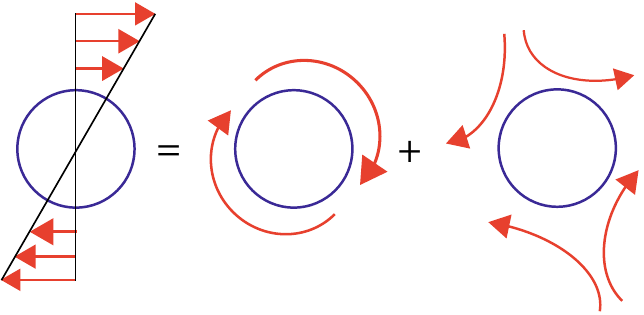
Figure 2. A sphere in shear can be decomposed into a sphere in rotation and a sphere in